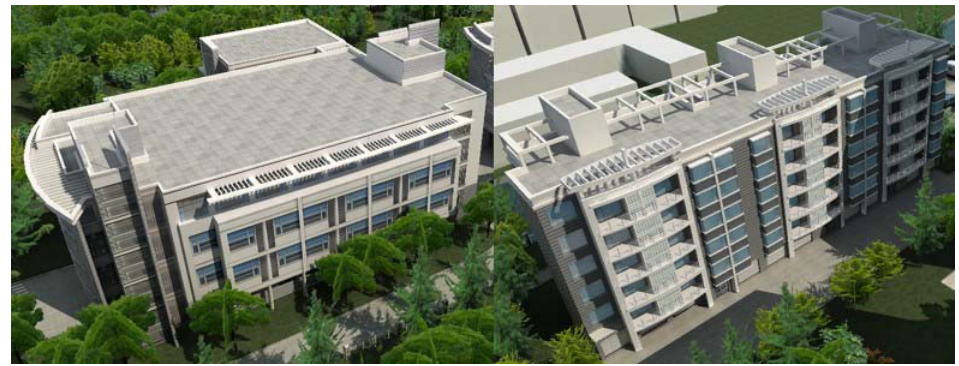
Figure 12. Two highly detailed 3D building models in the high-tech park.